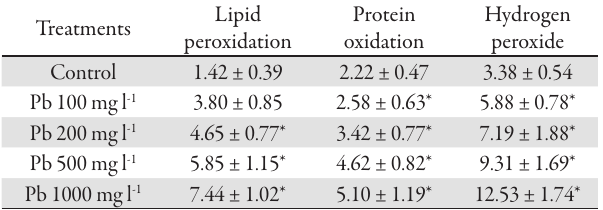
Tab. 2 . Effect of lead on lipid peroxidation (nM g -1 fresh weight), protein oxidation (nM carbonyl mg -1 protein) and hydrogen peroxide (µM g -1 fresh weight) in radish ( Raphanus sativus ) seedlings